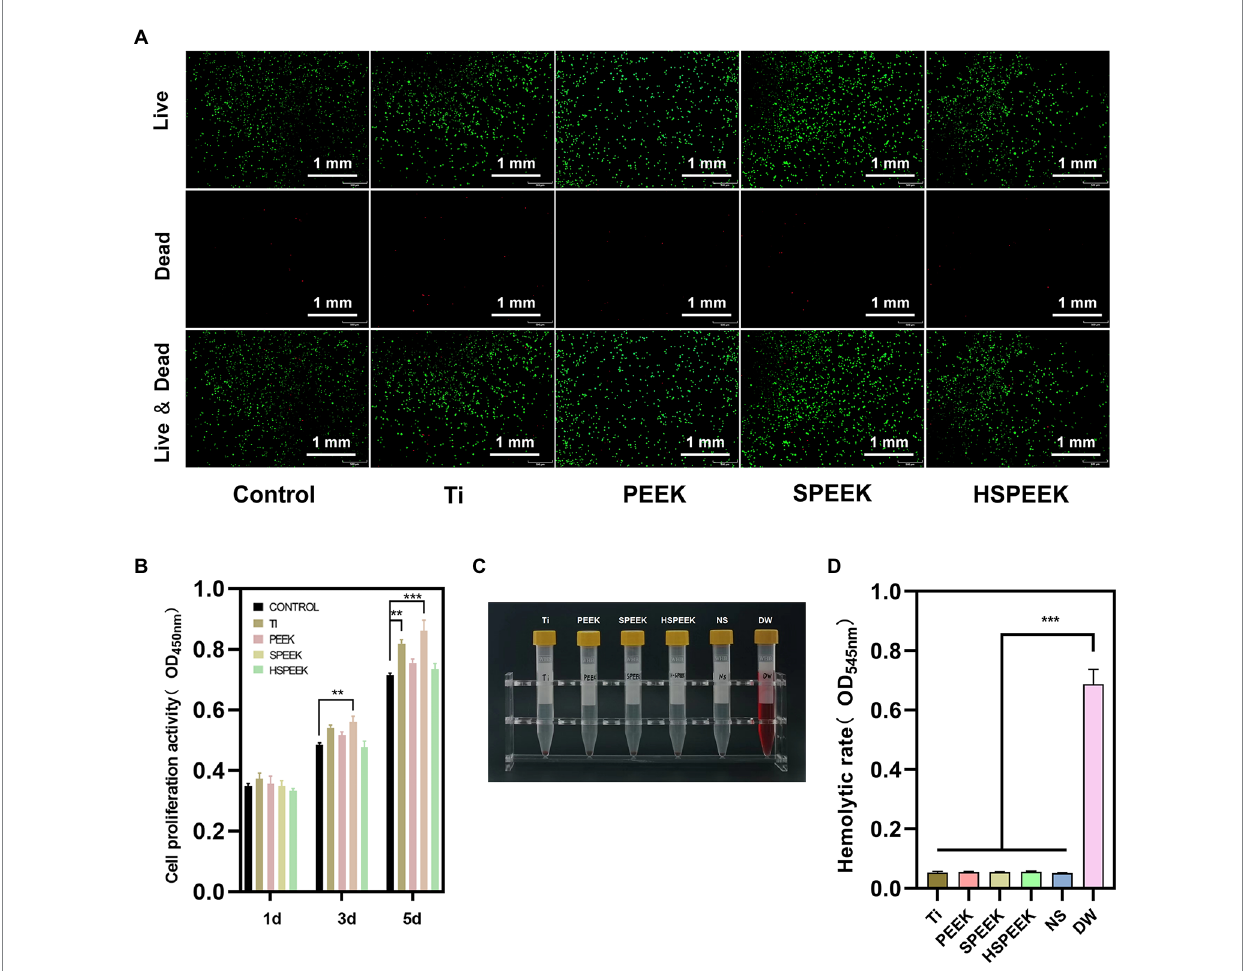
FIGURE 4 (A) Live/dead staining images of L929 cells after coculture with Ti, PEEK, SPEEK and HSPEEK extracts for 24 h, (B) The proliferation of L929 cells after 1, 3 and 5 d of coculture with sample extracts from each group, (C) Photographs of rabbit blood supernatant after 1 h of incubation with samples from each group, and (D) Hemolytic rate of samples from each group. ( n = 3, ** p < 0.01, *** p <